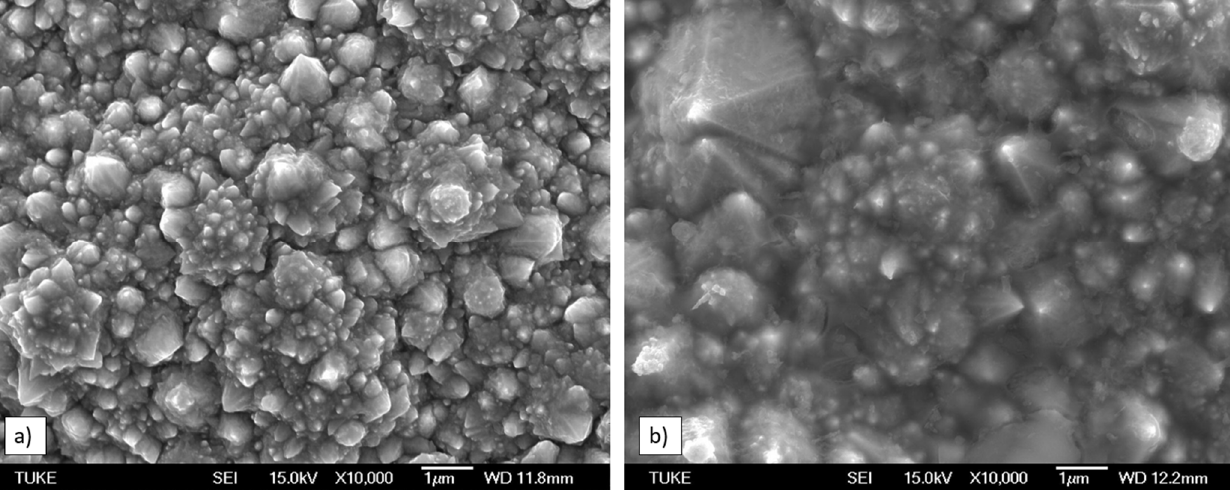
Table Table 3. Micro geometrical characteristics of copper substrate and Ni-Co coatings.